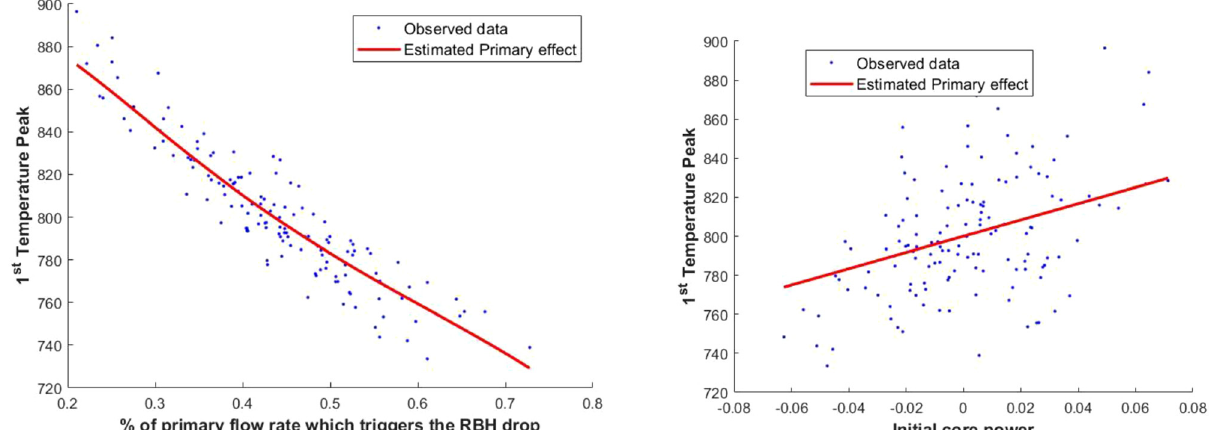
Fig. 6. Dependency of the cladding 1 rt temperature peak to the criterion on the percentage of primary fl ow rate triggering the RBH drop (left) and the initial power (right).